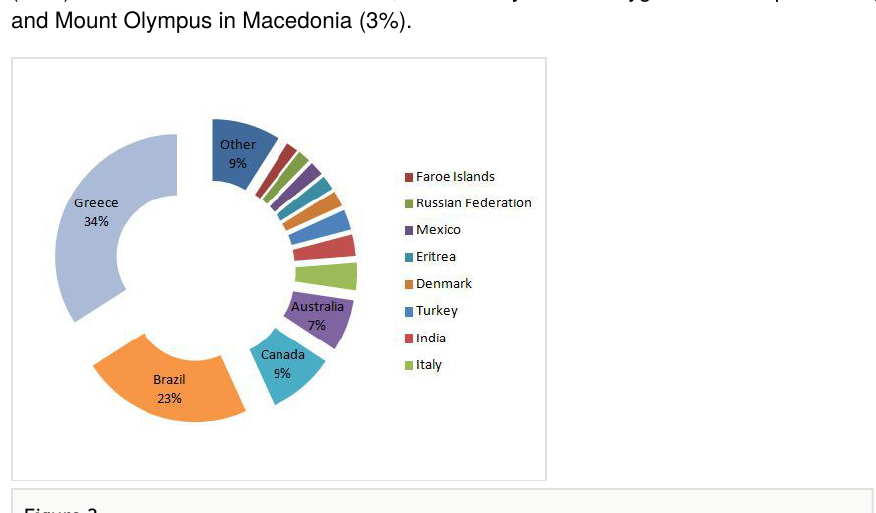
Figure 2. Distribution of the geographic origin percentage of avian specimens deposited in ZMUA collection. Parts without labels on the chart represents percentages below 5%. Countries pooled in the “other” category refer to localities with representatives’ percentage below